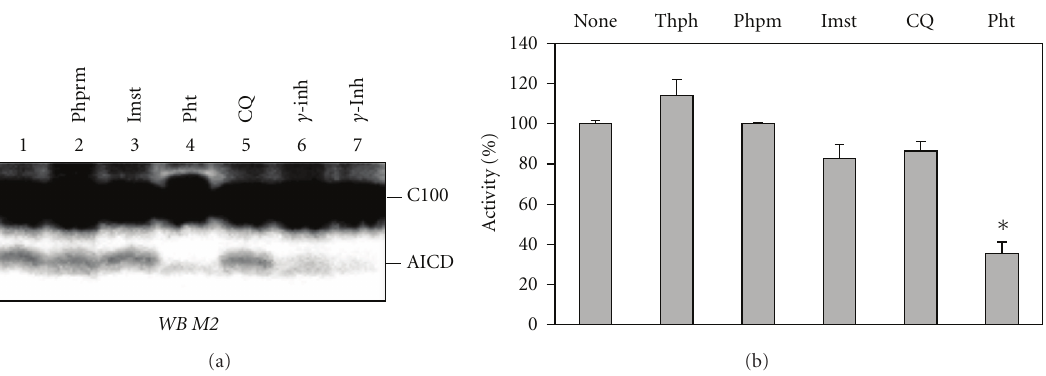
Figure 2: E ff ect of metalloprotease inhibitors, and metal chelators on γ -secretase. Chelators and inhibitors were added as DMSO solutions (final DMSO concentration 2.5%) to the guinea pig brain γ -secretase/C100-3XFLAG reactions. (a) Representative western blot of γ -secretase assay in the presence of various inhibitors. Phpm, phosphoramidon; Ilmst, ilomastat; Pht, phenanthroline; CQ, clioquinol; γ -inh, L-685,458, used at 10nM (lane 6) and 100 nM (lane 7). (b) E ff ect of metalloprotease inhibitors on the γ -secretase assay. Activity is expressed as the % of substrate converted into AICD, as determined from band density analysis with GeneTools software. The error bars represent SEM. Inhibitor concentrations were selected as follows: thiorphan, 250 nM; phosphoramidon, 25 μ M; ilomastat, 250 nM; phenanthroline, 5mM; clioquinol, 100 μ M.